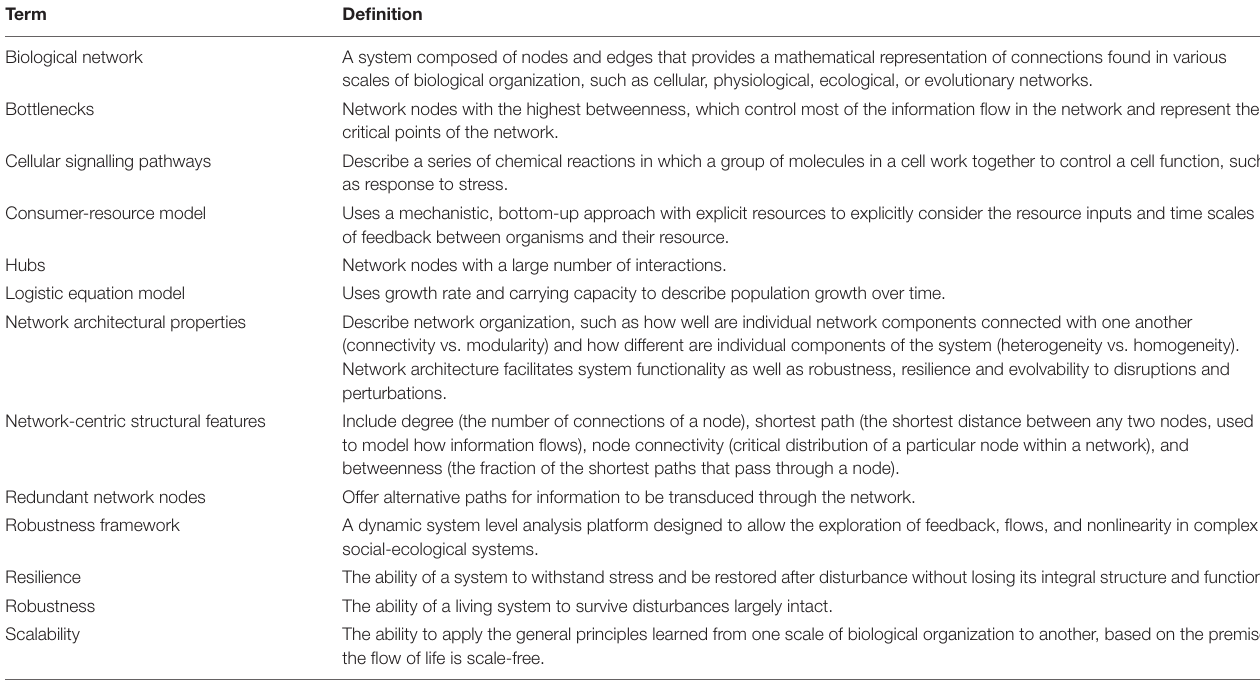
TABLE 1 | Definitions for key terms used. Term Definition Biological